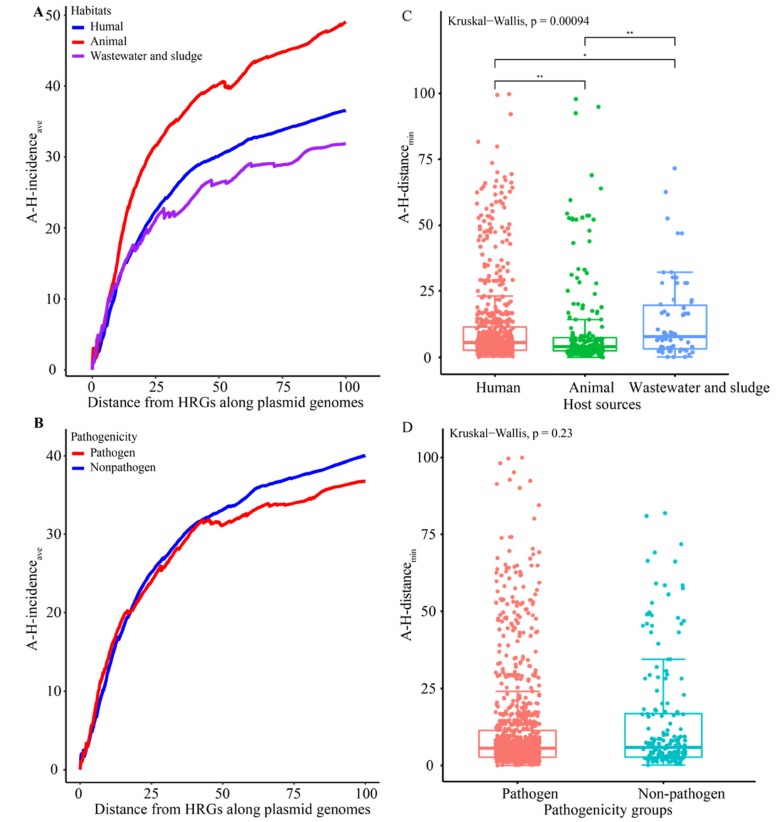
Figure 4. ARG and HRG co-distribution by the host source ( A , C ) and pathogenicity ( B , D ). ( A , B ) Change in the A-H-incidence ave (the average number of ARGs within a specified distance of HRGs among all plasmids with an increased distance. ( C , D ) A-H-distance min (average minimum distance between ARGs and HRGs among all plasmids. * p < 0.05 and ** p < 0.01 based on Wilcoxon rank-sum test after a significant